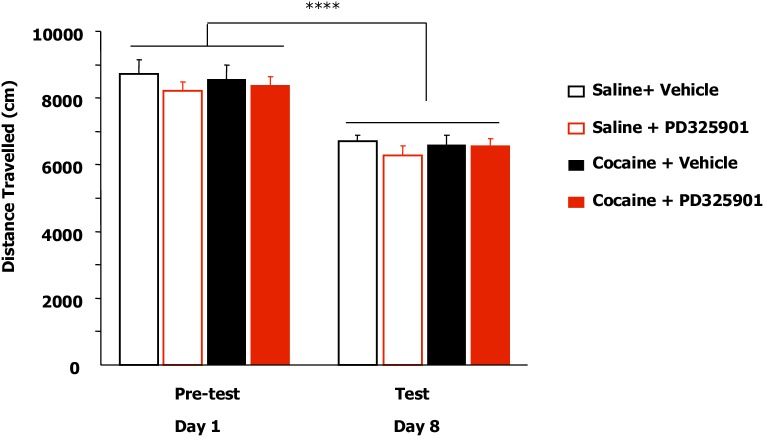
PD325901 does not influence levels of locomotion during the conditioned place preference.Locomotion (expressed as distance travelled) in the CPP apparatus during the pre-test- on day 1 in the absence of any treatment and 1 hr after PD325901 injection during the probe test on day 8. In the pre-test, no statistically significant difference was present among groups (one-way ANOVA, distance travelled, F3,38 = 0.311, p=0.817), indicating that all groups used for the experiment did not differ in their basal levels of explorativity. On day 8, half of the mice received an injection of PD325901 (10 mg/kg) or vehicle in their home cage and 1 hr later were let free to explore the CCP apparatus. PD325901 did not appear to affect explorativity as distance travelled of the PD325901-treated and the vehicle-treated groups did not statistically differ (one-way ANOVA, F3,38 = 0.224, p=0.879). Two-way ANOVA for repeated measures showed that levels of locomotor activity were comparable among the four groups (F3,35 = 0.513, p=0.676). There was a significant main effect of time on spontaneous locomotion across the two days of testing (F1,35 = 27.287, p<0.0001), but no significant time x group interaction (F3,35 = 0.78, p=0.971), demonstrating that there were no differences in the rate of explorativity of the four groups. ****p<0.0001. Data are shown as mean with SEM.